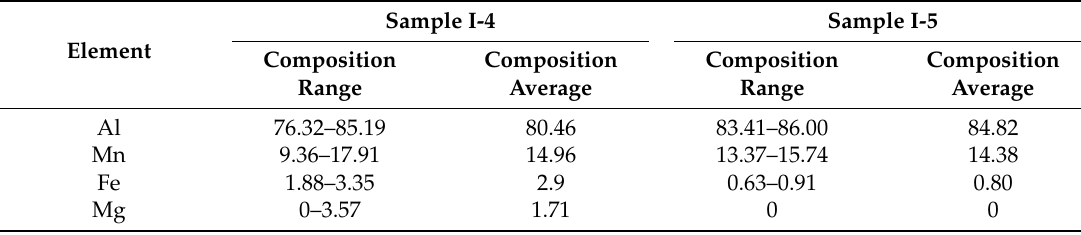
Table 2. Composition of intermetallic Al 6 (Fe,Mn) measured by EDX (at%).